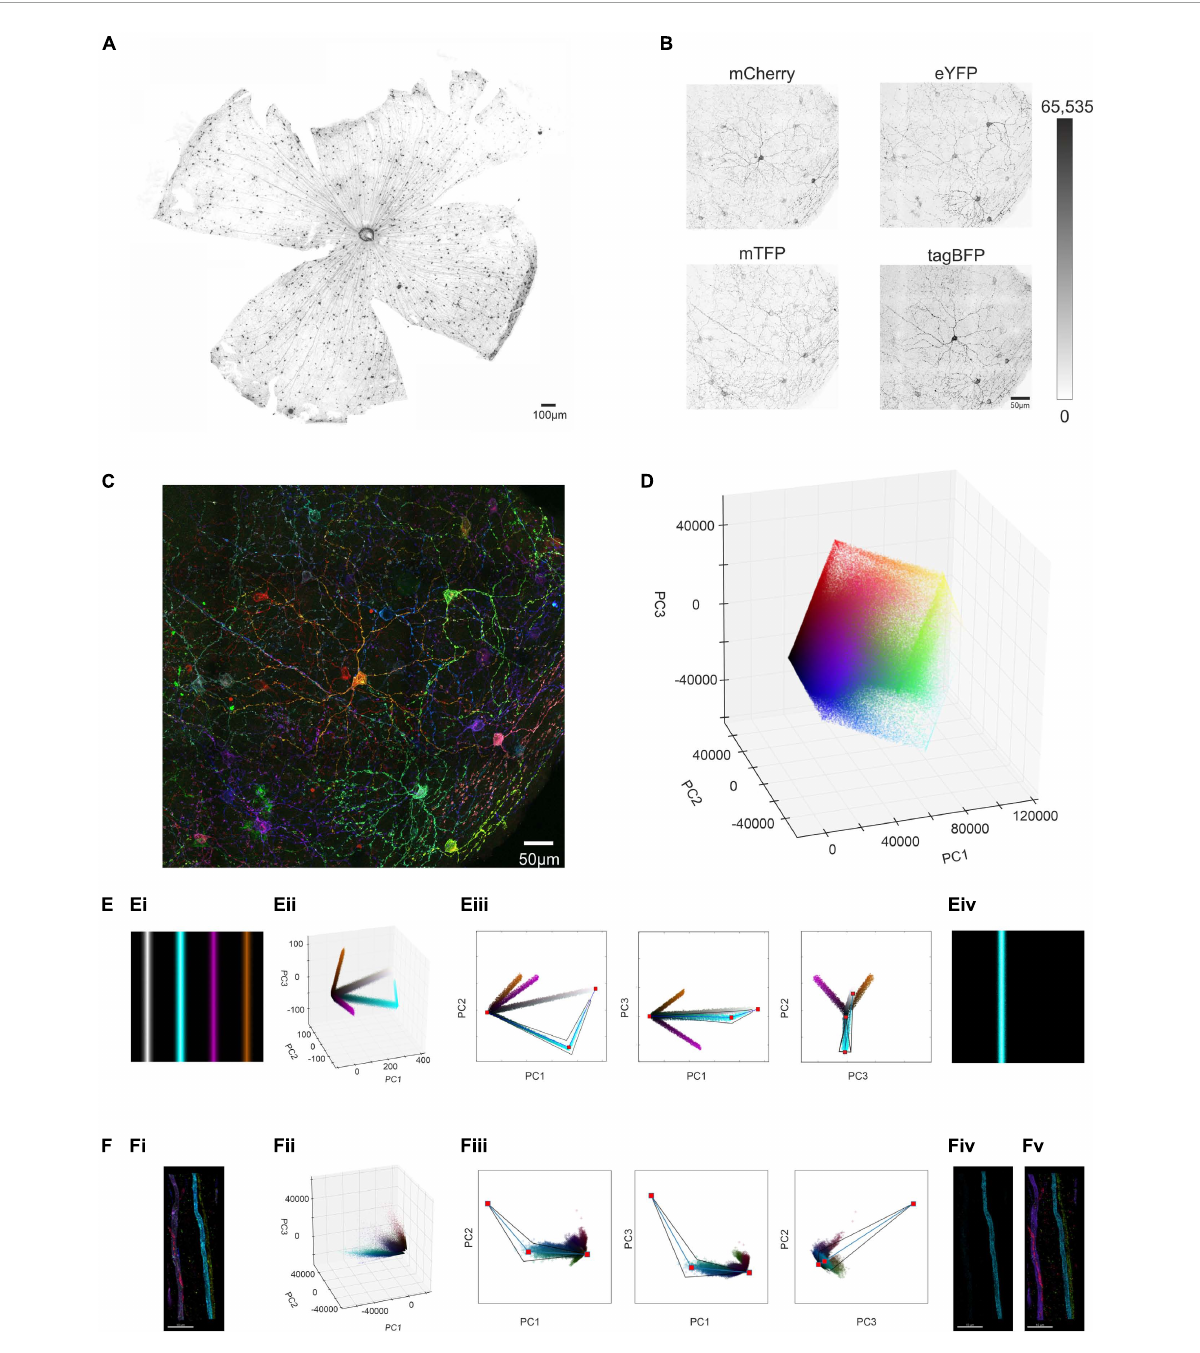
FIGURE1 Identifying and isolating voxel clusters from multi-color images in Principal Component Space. (A) Following a unilateral intravitreal injection of Brainbow viruses into an Opn4 Cre / + mouse, immunohistochemical labeling against the mCherry reporter protein (in monochrome) demonstrates strong labeling of cells distributed across the retinal ganglion cell layer. (B) Maximum projection of the immunohistochemically labeled mCherry, mTFP eYFP and tagBFP reporter proteins from a region of interest (ROI) from an Opn4 Cre / + retina demonstrates variable reporter protein expression between individual intrinsically photosensitive retinal ganglion cells (ipRGCs) in the Opn4 Cre / + retina. (Note weak expression of tagBFP and high background noise) (C) Representative confocal image of the ROI shows stochastic labeling of individual cells when the combined maximal projection of the three individually recorded channels mCherry (pseudocolored Red), eYFP (pseudocolored Green) and mTFP (pseudocolored Blue) from panel (B) , following immunohistochemical labeling. (D) Principal component analysis (PCA) conducted on the intensity values of the constituent voxels of ROI in panel (B) were plotted in a 3D representation of PC space (PC1 vs. PC2 vs. PC3). (E,Ei) Simple simulated image of four colored bars, with hue and saturation kept constant across each bar, but with lightness varying from 0 (black) at the outer edge to either 0.6 (in the case of purple and orange) or 0.9 (in the case of cyan and gray) in the center (see online methods and Supplementary Figure 1 for further explanation). (Eii) 3D representation of PC space from the image in panel (Ei) shows that the